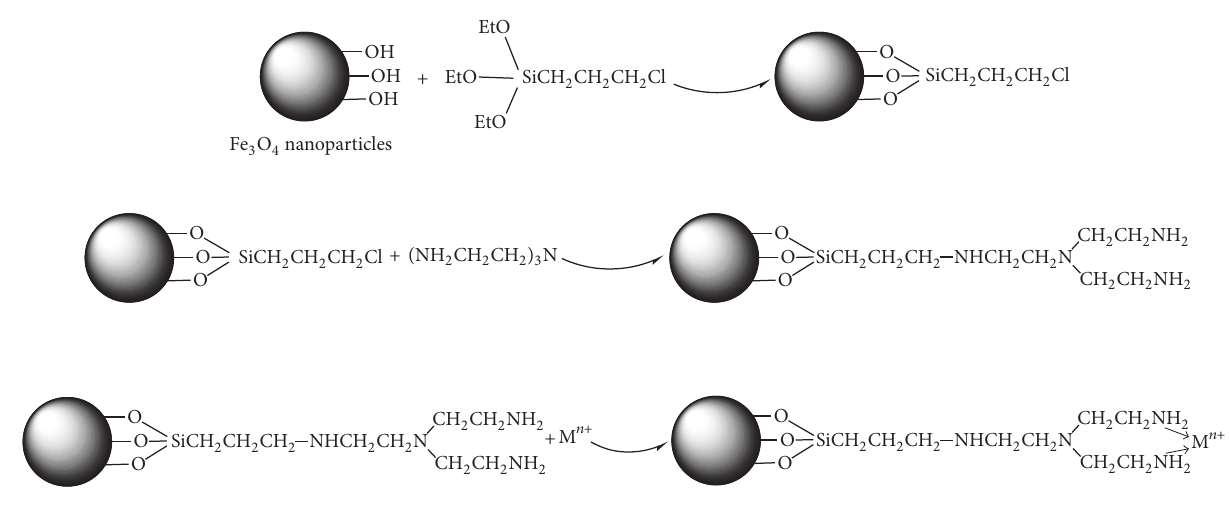
nano-particles. 4